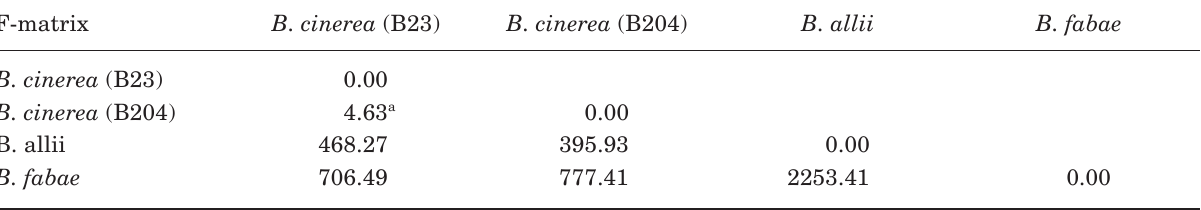
Table 2. Discriminant analysis of the conidial length and width of Botrytis cinerea isolates B23 and B204, B. allii and B. fabae (F = 4.66). 0.01 (1) 2,395